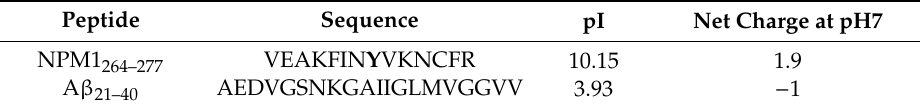
Figure 1. Chemical structures of square-planar complexes investigated in this study. Table 1. Peptide sequences analyzed in this study.